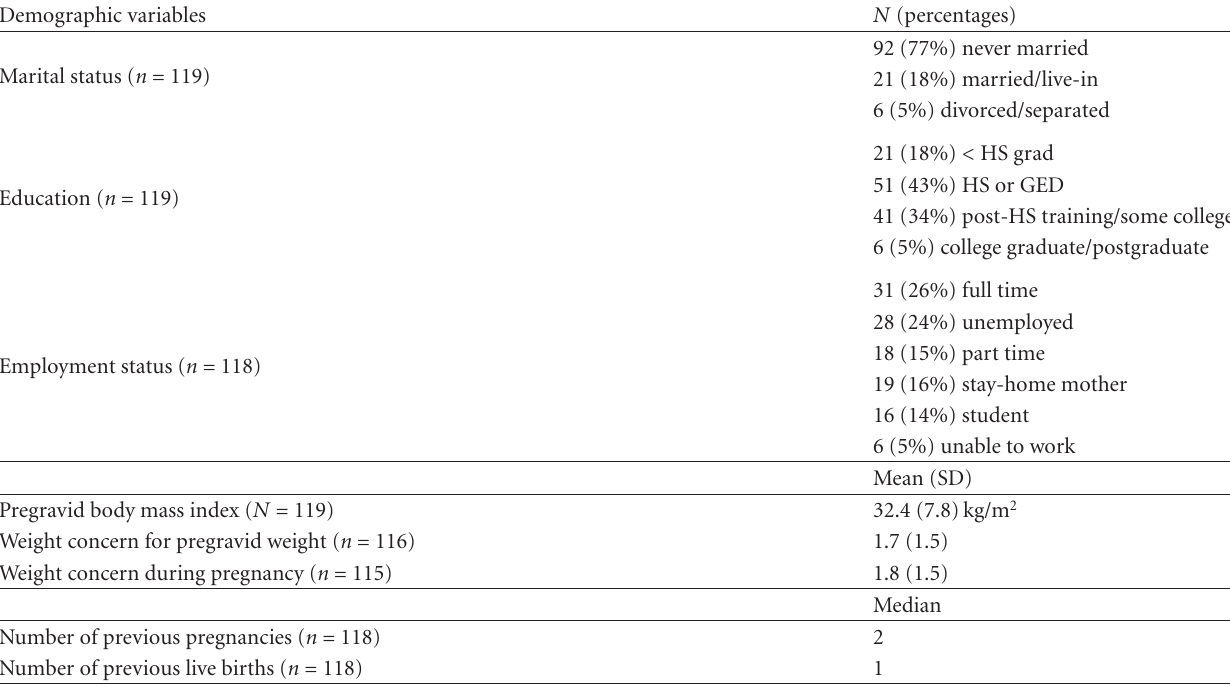
Table 1: Demographic information.